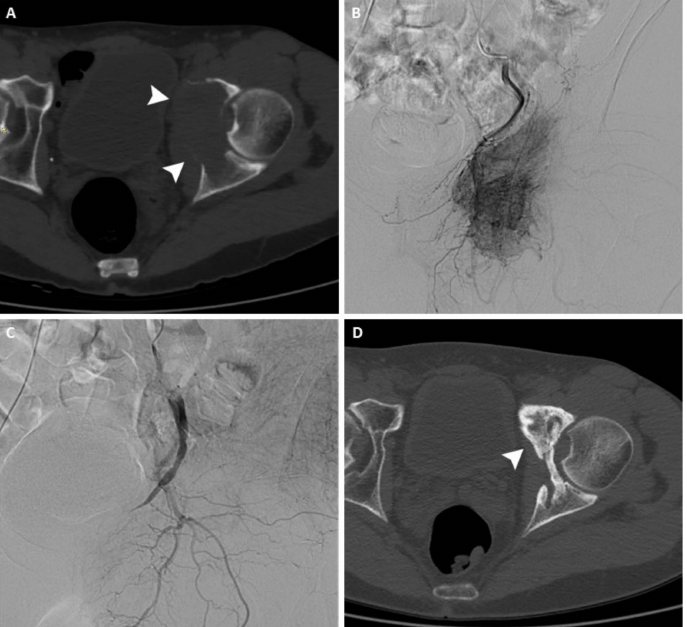
Figure 1. ( A ) Axial CT scan of the pelvis of a 63-year-old man with a painful left acetabular bone metastasis from kidney cancer (arrowheads). ( B ) Arteriography shows pathological vascularization originating from branches of the internal iliac artery. ( C ) After arterial embolization, arteriography demonstrates complete occlusion of the feeding vessels. ( D ) Axial CT scan performed 12 months after treatment shows signs of re-ossification and local disease control